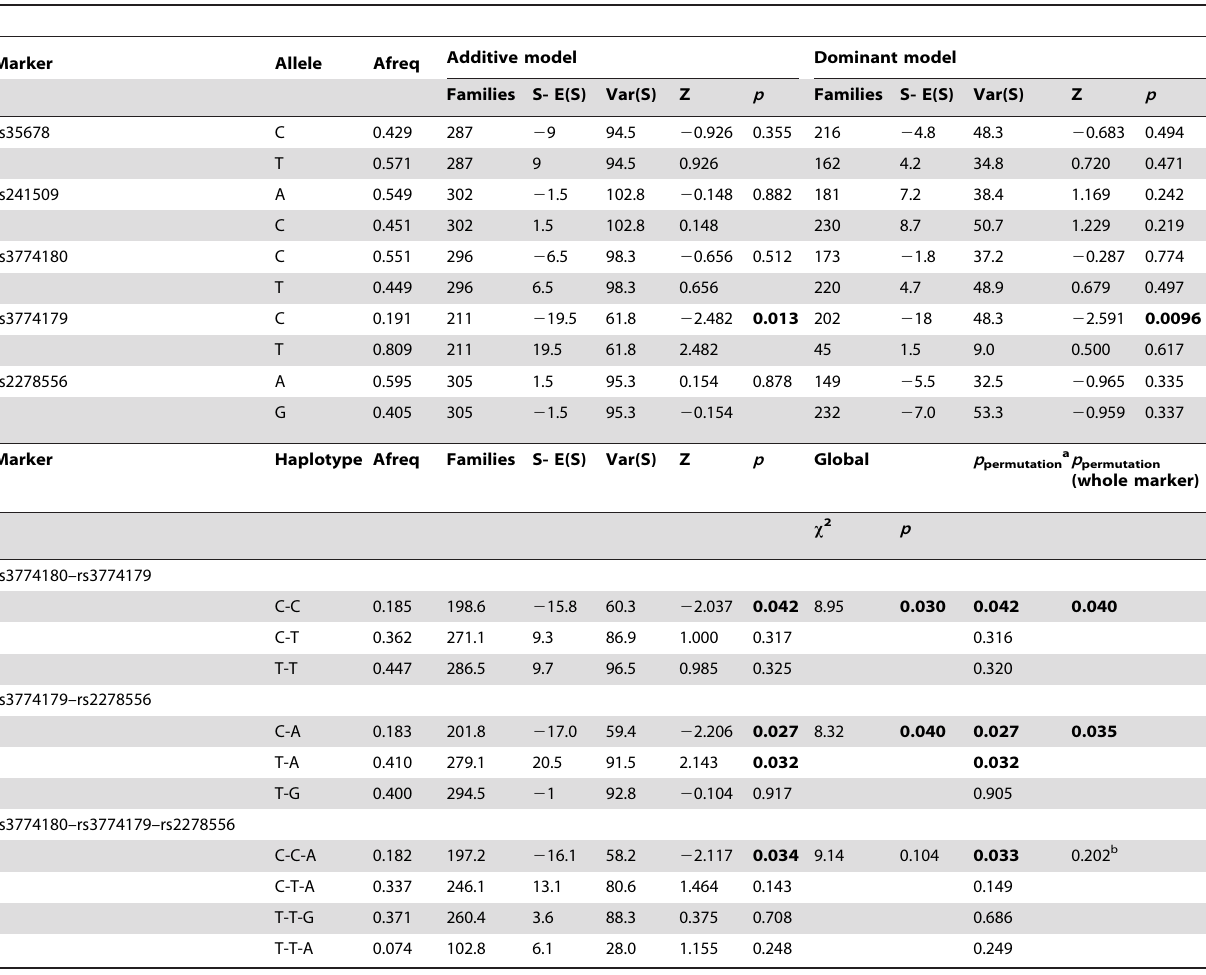
Table 2. Results of association between 5 SNPs in ATP2B2 and autism and haplotype analyses in 427 trios of Han Chinese descent.